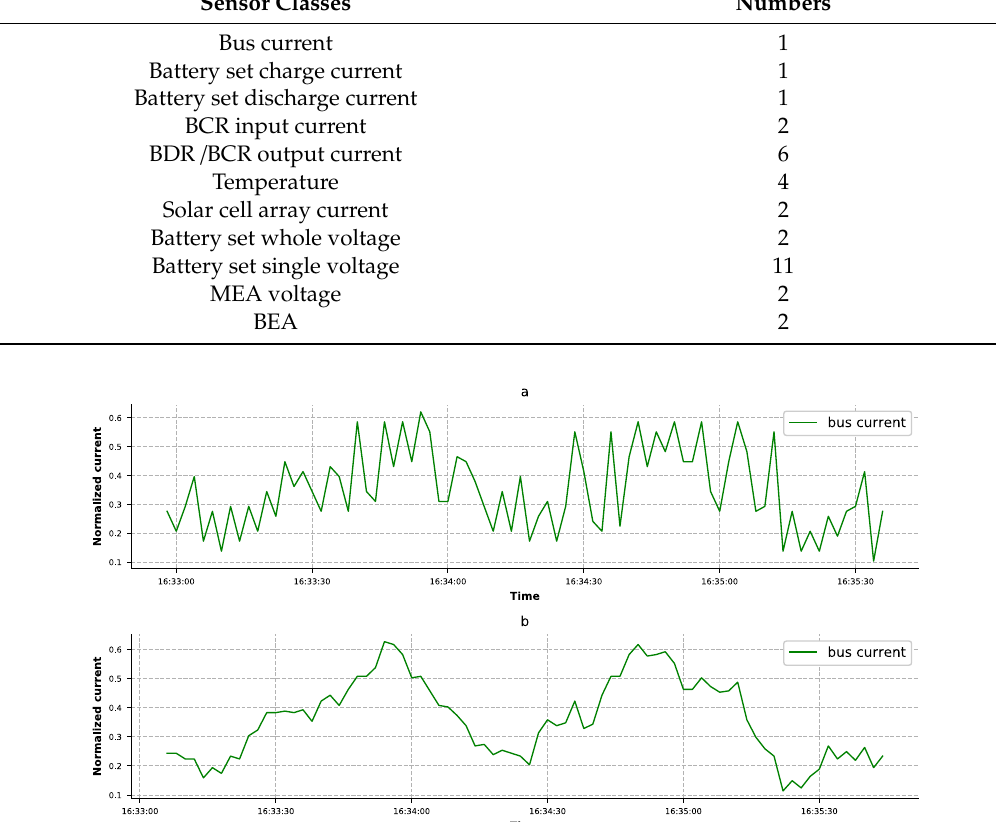
Table 2. Description of sensors.